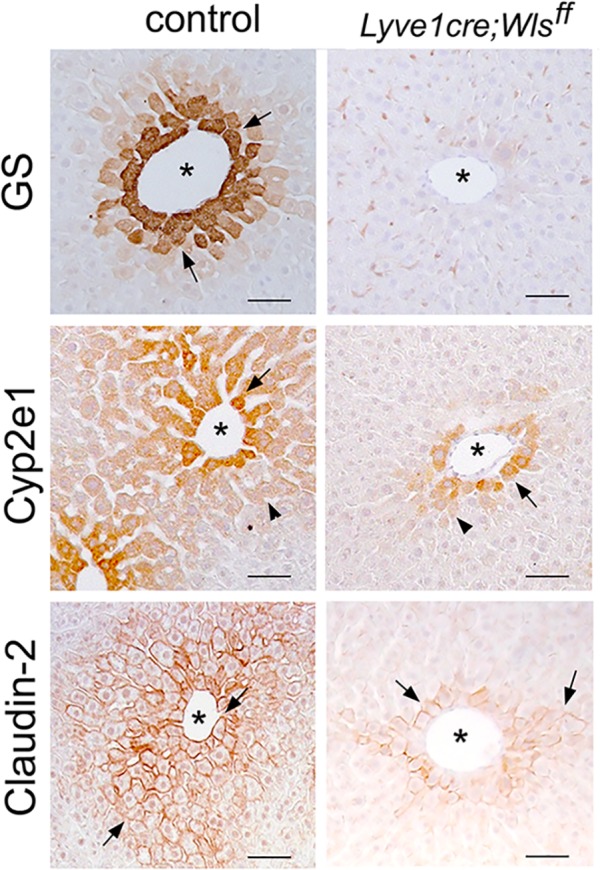
Wls deletion in the adult endothelium disrupts liver zonation.Immunohistochemistry results showing reduced expression of GS, Cyp2e1 and Claudin-2 proteins in perivenous (asterisks) hepatic areas following sinusoidal (Lyve1-Cre) Wls deletion. Each image represents 2–3 individual livers. Scale bars: 50 µm.